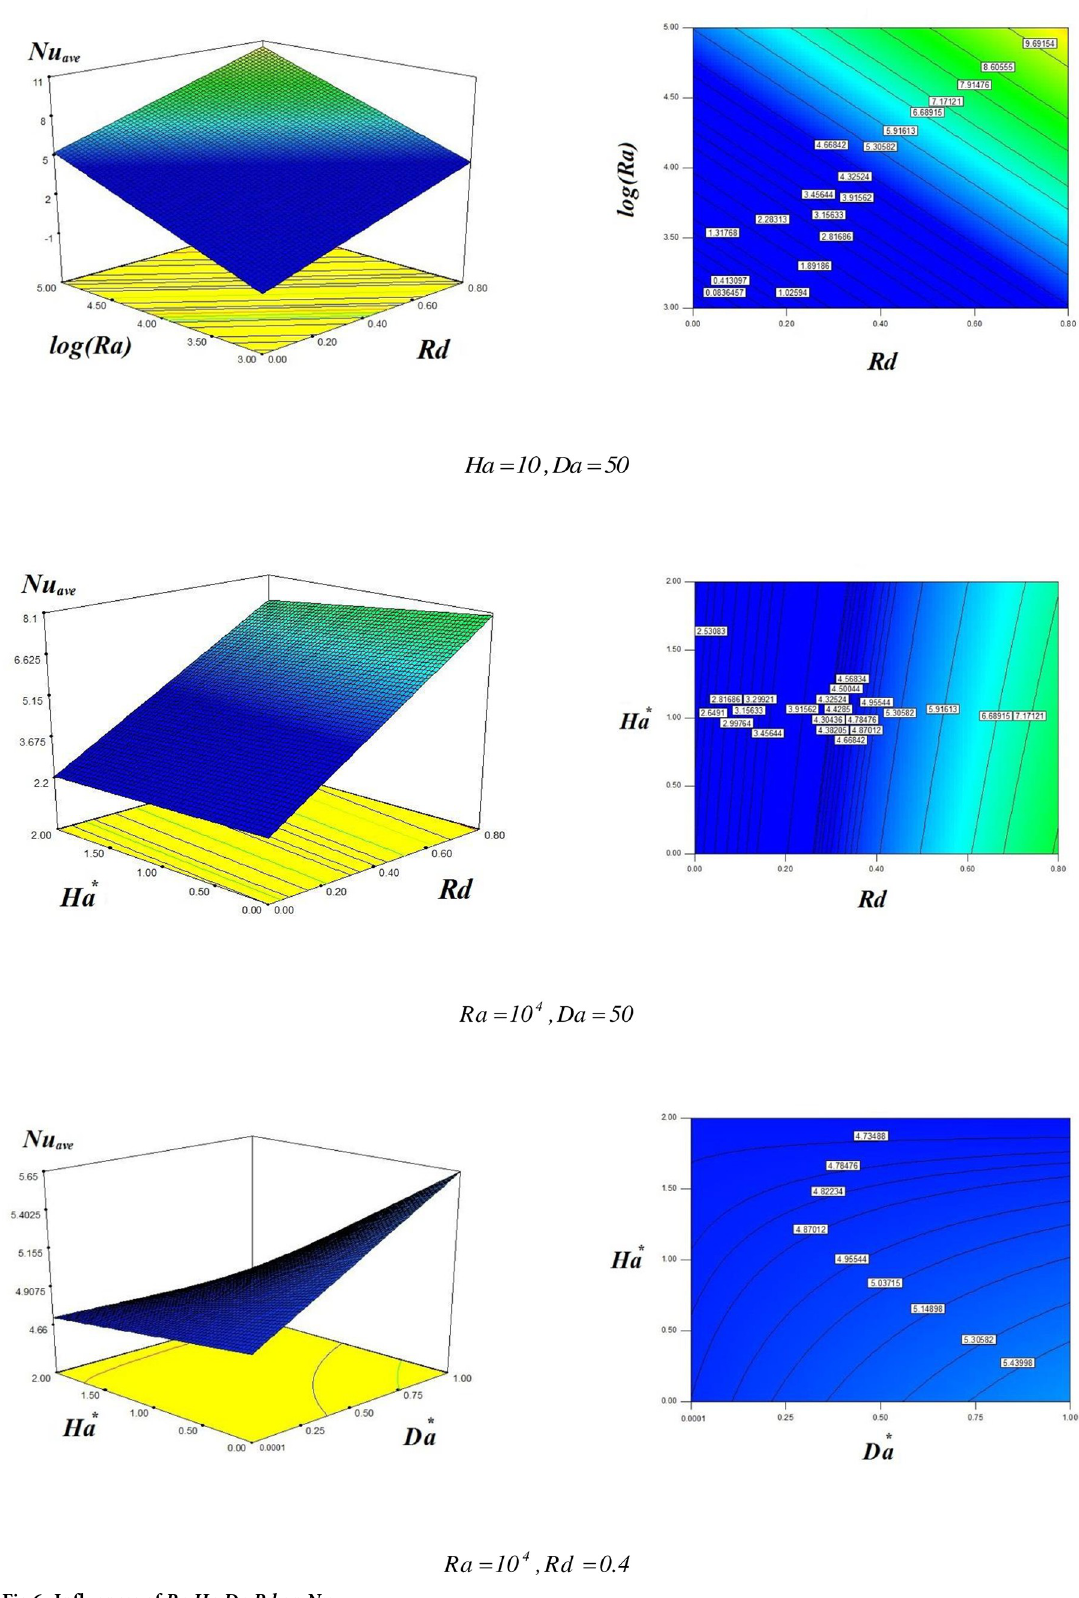
Fig 6. Influences of Ra , Ha , Da , Rd on Nu ave . https://doi.org/10.1371/journal.pone.0251744.g006 PLOS ONE | https://doi.org/10.1371/journal.pone.0251744 July 1,